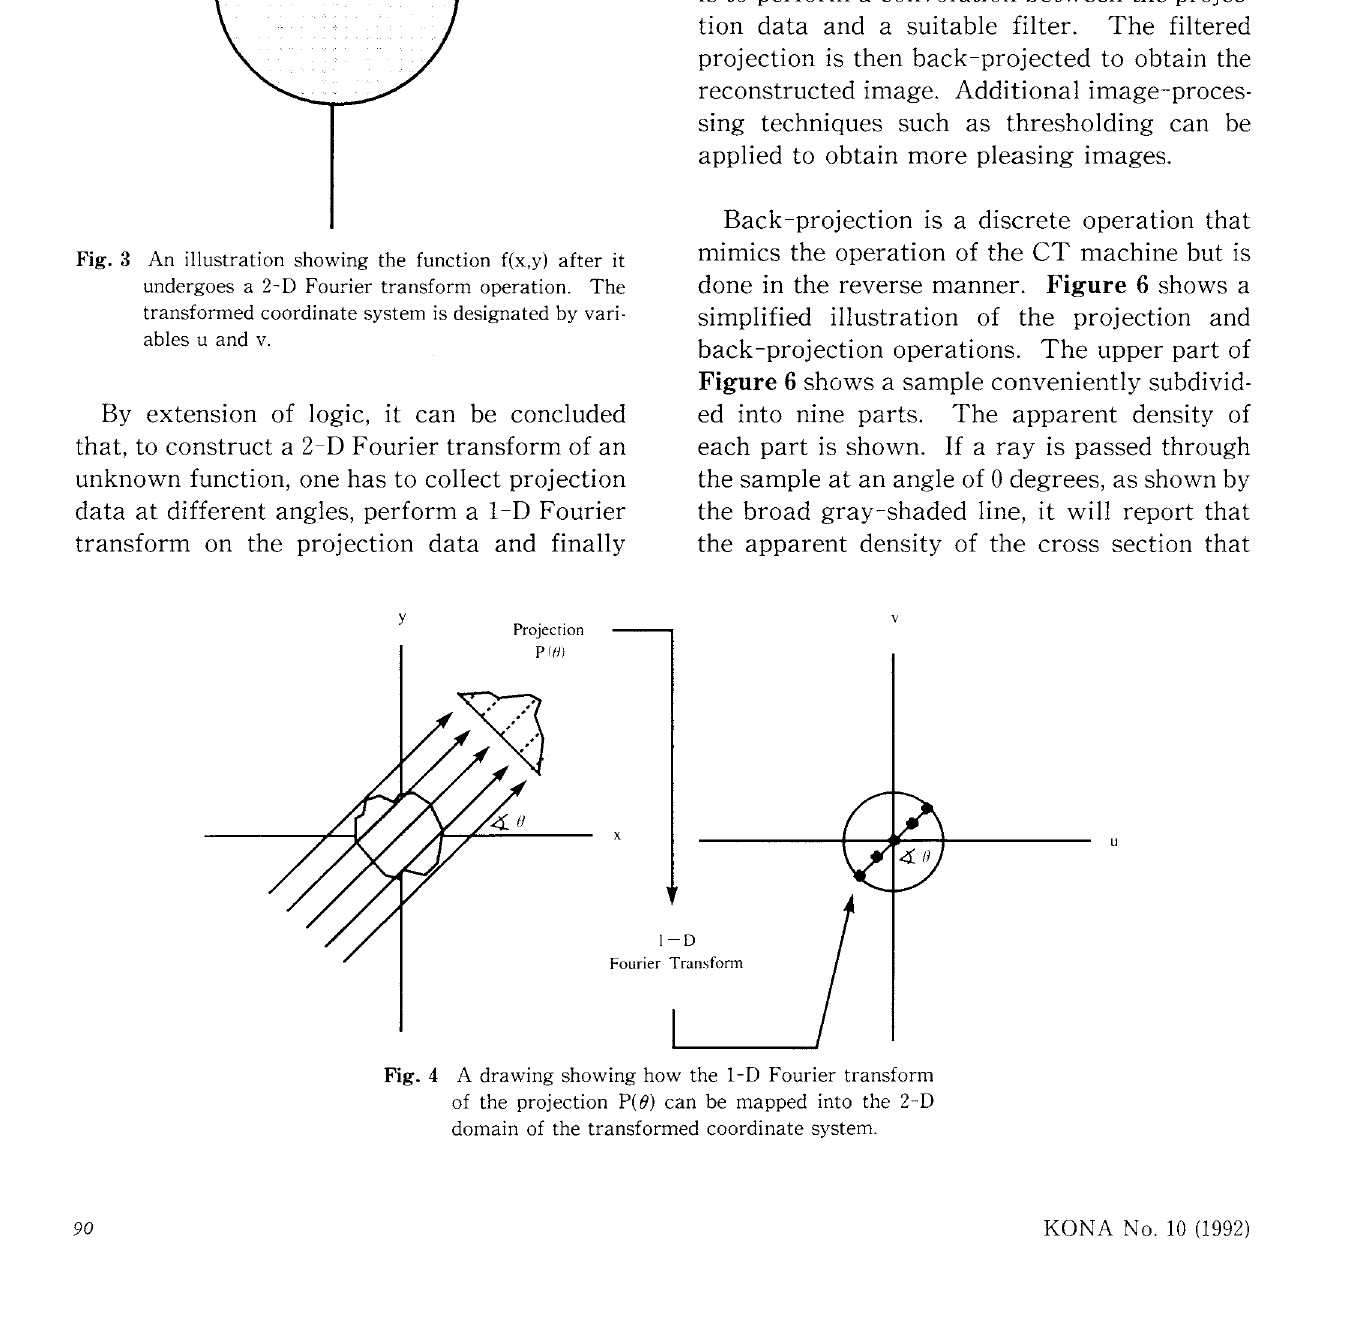
Fig. 4 A drawing showing how the 1-D Fourier transform of the projection P(tl) can be mapped into the 2-D domain of the transformed coordinate